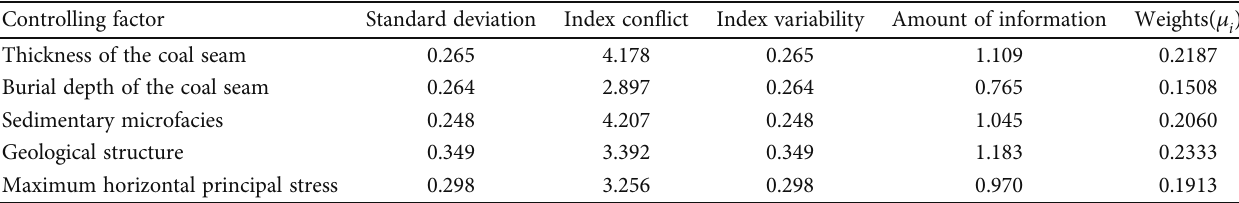
Table 2: Calculate the weight result by CRITIC method.